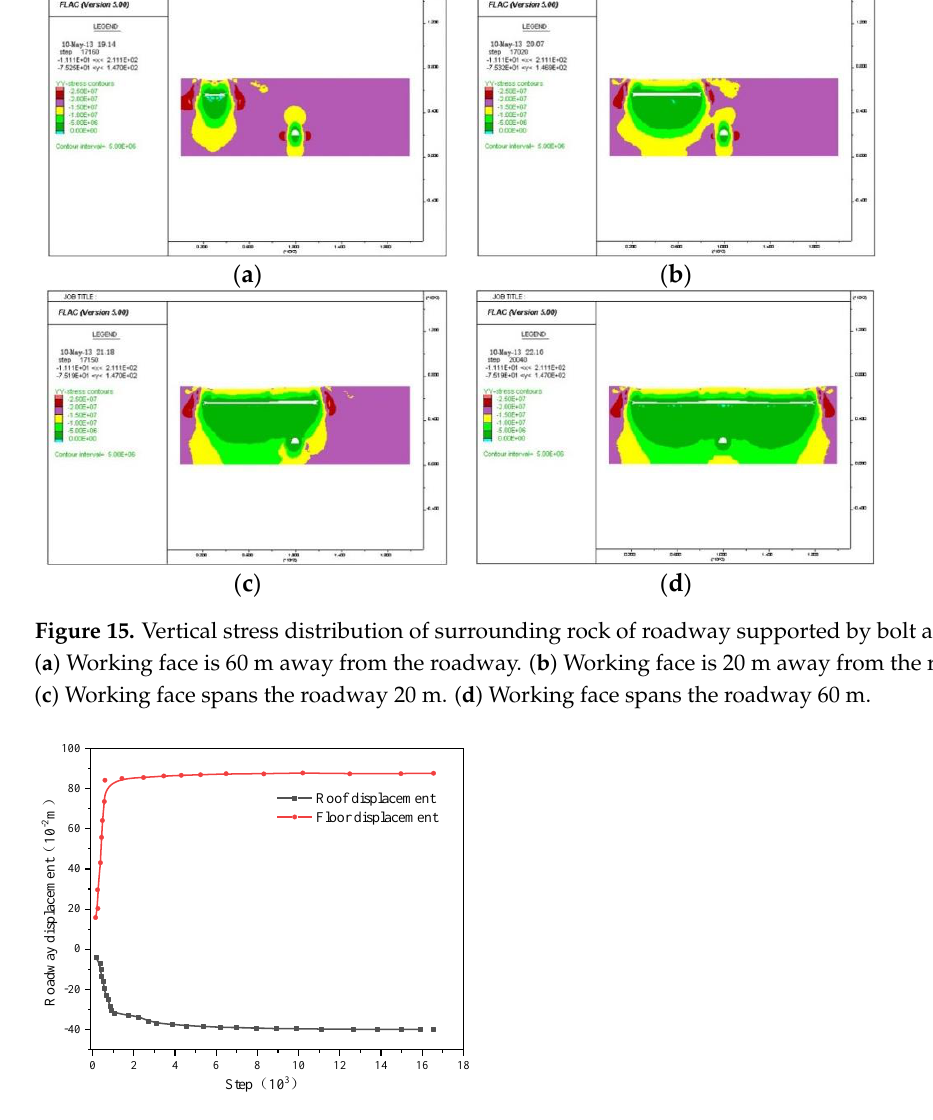
Figure 16. Vertical displacement of working face when crossing roadway 60 m.